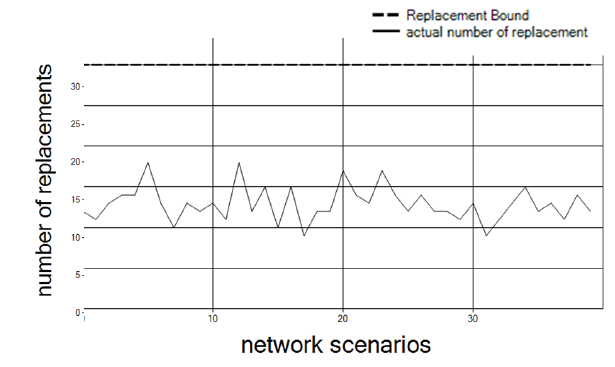
Figure 8. Replacements bound and actual number of